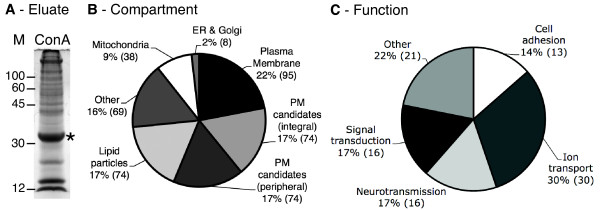
Protein identification from head PM preparation. A - SDS PAGE analysis of proteins eluted from the ConA in a head PM preparation from ~20 g of flies. Gel is stained with colloidal coomasie blue. Asterisk - prominent ConA band that coelutes from the column, probably due to tetramer disassembly. The presence of this band prevents us from an accurate protein determination from our preparation; however we estimate there to be 50-100 μg protein on this gel. Three such preparations were combined for our MudPIT analysis. B - Pie chart showing the breakdown of protein types and compartments identified with high reliability in our MudPIT analysis. Compartment assignments were taken from annotations at Flybase.org in conjunction with our hydropathy analsysis (see text and Table 2). Plasma Membrane -integral or peripheral plasma membrane proteins; PM candidates (integral) - integral membrane proteins with no current assignment to any compartment (see text); PM candidates (peripheral) - have no predicted transmembrane domain and no currently assigned compartment (see text); Other - ribosome, cytoskeleton, synaptic vesicle, cytoplasmic; Mitochondria - mitochondrial; ER & Golgi - endoplasmic reticulum and Golgi apparatus; Lipid particles - lipid particles. Some of these may also be present in mitochondria and/or ER (see text for discussion). C - Pie chart showing the functional annotation of proteins identified in the plasma membrane fraction in B. 78% are associated with cell surface activities (Cell adhesion, Ion transport, Neurotransmission, Signal Transduction). See Additional File 5 for the specific assignment of each protein.